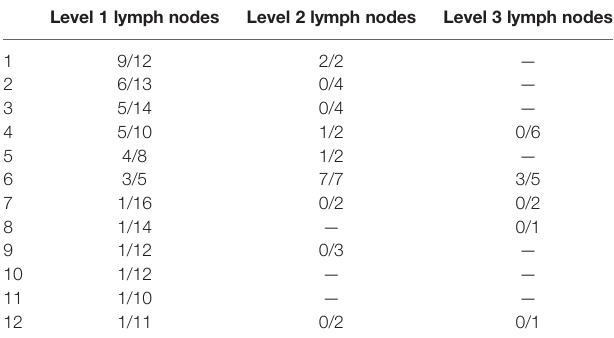
TABLE 3 | Metastatic status of contralateral axillary lymph nodes.